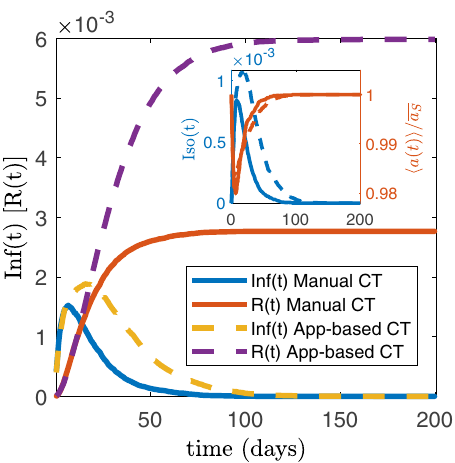
Fig. 5 Effects of manual and digital contact tracing on the epidemic active phase. We plot the temporal evolution of the fraction of infected nodes Inf ð t Þ , i.e., infected asymptomatic and infected symptomatic, and of the fraction of removed nodes R ( t ), for both manual and digital CT. In the inset we plot the temporal evolution of the fraction of isolated nodes Iso( t ) (right y-axis) and of the average activity of the population 〈 a ( t ) 〉 (left y-axis), normalized with a S . All curves are averaged on several realizations of the disorder and of the temporal evolution. We set ϵ ¼ f 2 ¼ 0 : 1, τ C = 3 days, r = r NA ¼ 3 : 1 and N = 5 × 10 3 . The distribution ρ ( a b S , S ) is given by Eq. (1), C with ν = 1.5. The curves for digital and manual CT are averaged respectively over 554 and 681 realizations and the errors, evaluated through the standard deviation, are smaller or comparable with the curves